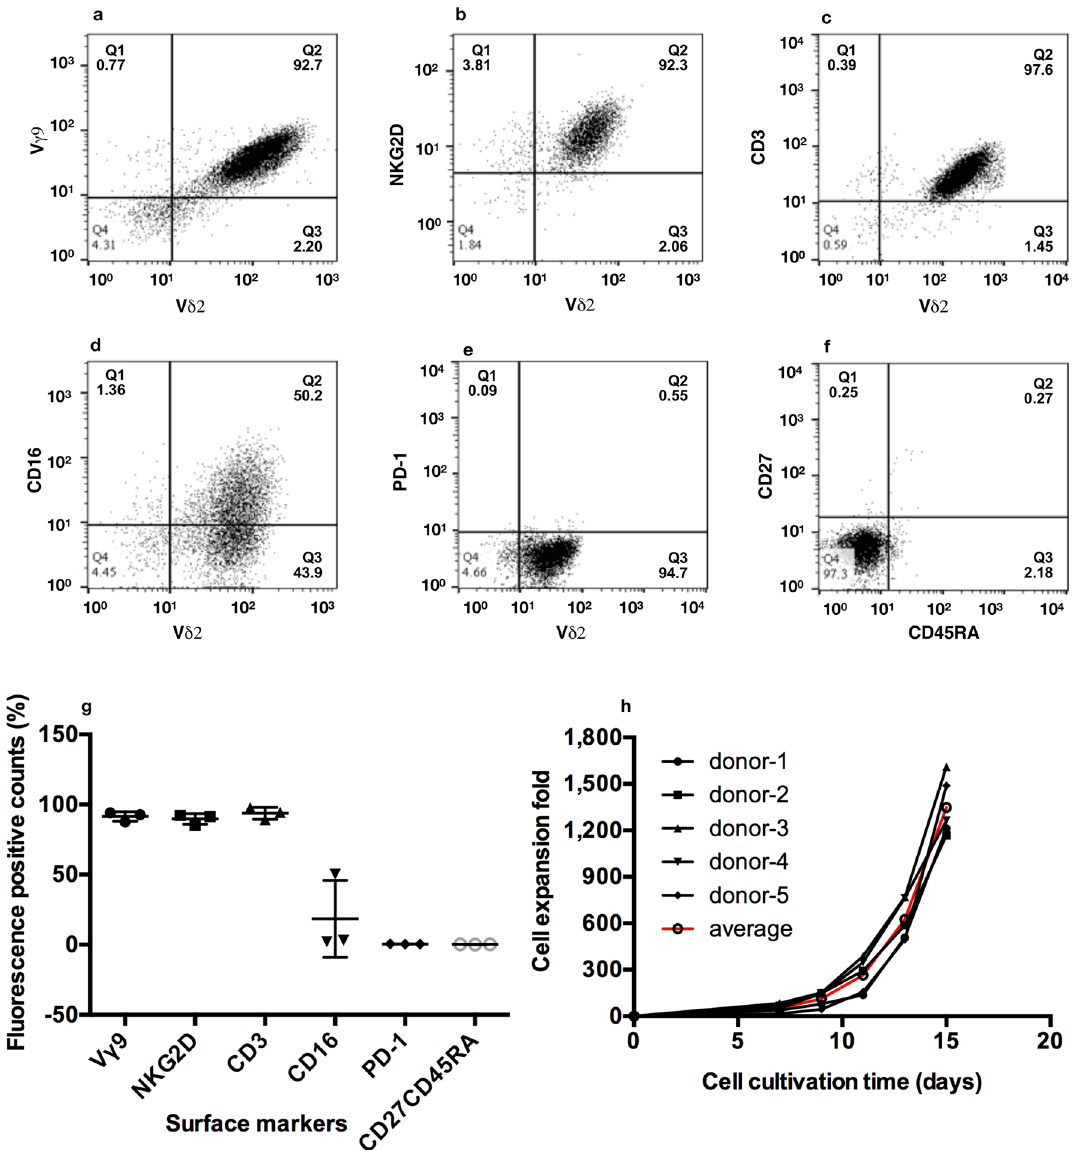
Figure 1. Immunophenotypic profiles of expanded human γ9δ2 T cells. The peripheral blood mononuclear cells (PBMCs) of healthy donors were isolated and grown in the medium formulated for the expansion of γδ T cells for 14 days. The expression of various surface markers was examined by staining with appropriate fluorochrome-labeled monoclonal antibodies (mAbs) and analyzed on a flow cytometer. Images were created using FlowJo software 10.0.0r1. ( a – f ) A set of representative surface marker dot plots of a donor’s expanded γ9δ2 T cells. ( a ) Cells were stained with an FITC-labeled mAb against Vγ9 T cell receptor (TCR) and a PE-labeled mAb against Vδ2 TCR to determine the purity of the expanded γδ T cells. The population of γ9δ2 T cells was identified by the expression of Vδ2 TCR and their expression of ( b ) NKG2D, ( c ) CD3, ( d ) CD16, and ( e ) PD-1 was evaluated. ( f ) The expanded γ9δ2 T cells were examined for the expression of CD27 and CD45RA. ( g ) A statistical graph presented the percentage counts of three donors’ expanded γ9δ2 T cells for the expression of various surface markers (Vγ9, NKG2D, CD3, CD16, PD-1, CD27, and CD45RA). Data were expressed as mean ± s.d. (n = 3). ( h ) Growth curve of γ9δ2 T cells. Five donors’ PBMC were cultured for the expansion of γδ T cells for 15 days. At indicated time points (day 0, 7, 9, 11, 15), the total cell number and γ9δ2 percentage were determined by trypan blue staining and flow cytometry analysis, respectively. The calculated cell numbers of expanded γδ T cells were plotted as a line graph with cell expansion fold versus cell cultivation time. Red line ( ): the average of five